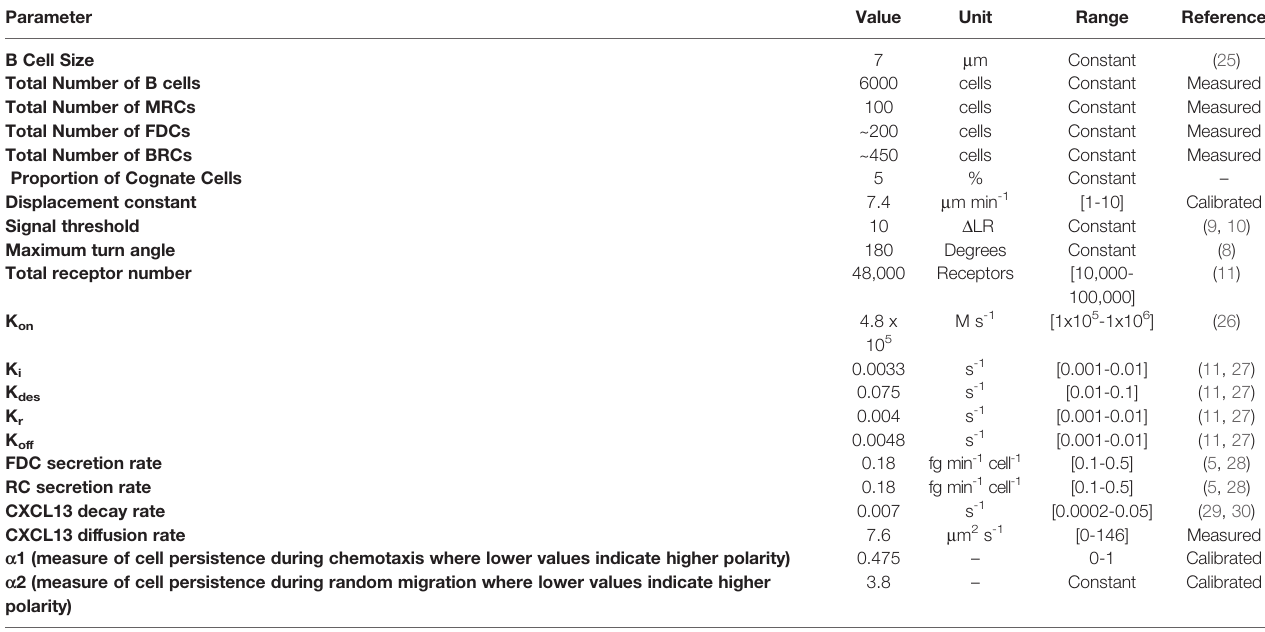
TABLE 2 | Summary of parameter